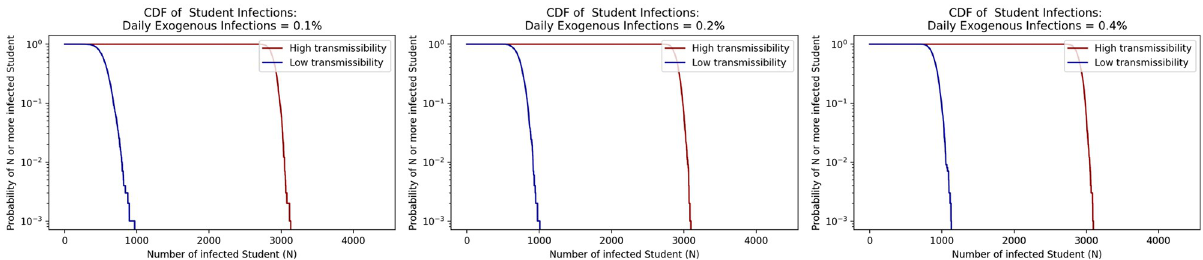
Fig 13. Sensitivity of model to daily community prevalence (e.g., exogenous infections rate parameter in the